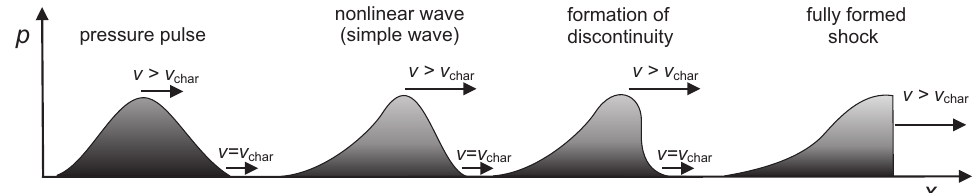
Figure 1: Schematics of the nonlinear wave evolution and shock formation process. The x-axis denotes the spatial coordinate 𝑥 , the y-axis the pressure 𝑝 . An initial large-amplitude pressure pulse leads to the formation of a nonlinear wave (a so-called simple wave). The wave crest propagates faster than the leading edge, which only moves at the characteristic speed of the medium ( 𝑣 > 𝑣 char ), which leads to wave steepening until a discontinuity is established and a shock wave has formed (adapted from Warmuth,